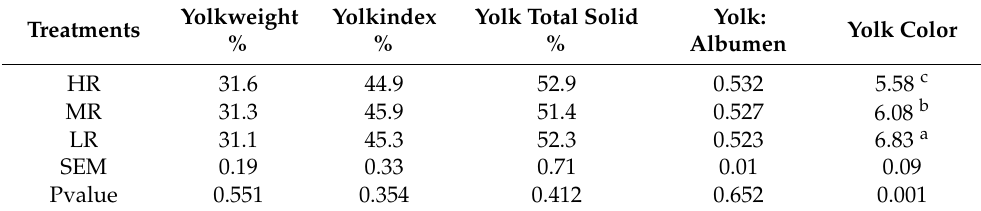
Table 4. Effect of ω -6/ ω -3 ratio on egg yolk quality of laying hens. Yolkweight Treatments